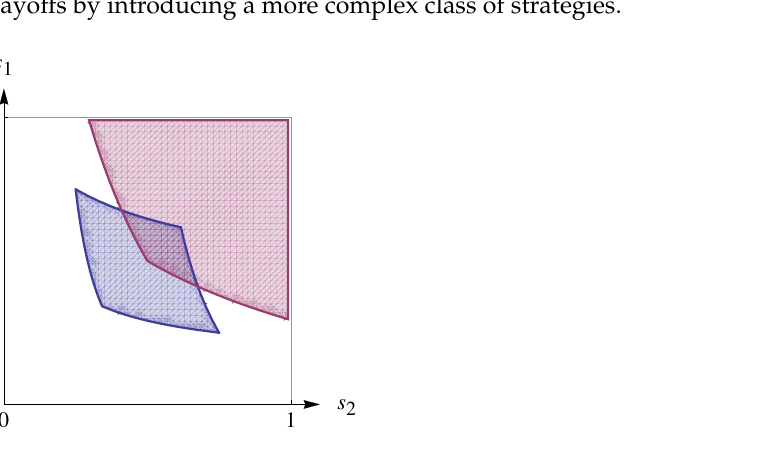
Figure 6. The blue set is the set of all ESDs for G NB ; the red set is the set of all stationary distributions such that both players get payoffs greater than 7 (the second-highest payoff in the one-shot